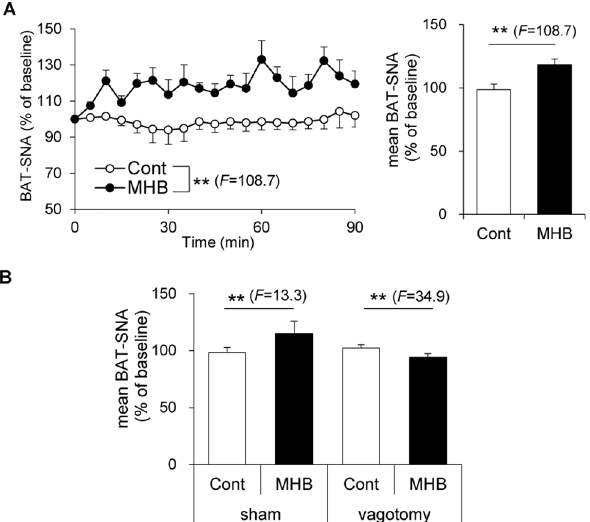
Fig 3. Single oral administration of MHB elevated BAT-SNA in rats. (A) Time course of BAT-SNA changes taken every 5 min and mean BAT-SNA over 0- to 90- min period. Urethane-anesthetized rats were administered 10 mg/kg of MHB. Data were calculated as a percentage of baseline, and as means ± SEM. n = 3 rats/group. ** P < 0.01 (by ANOVA with repeated measures). (B) Effects of 2 mg/kg MHB on mean BAT-SNA over 0- to 90- min period in sham-operated or vagotomized rats. Data are presented as means ± SEM. n = 3 rats/group. ** P < 0.01 (by ANOVA with repeated measures).